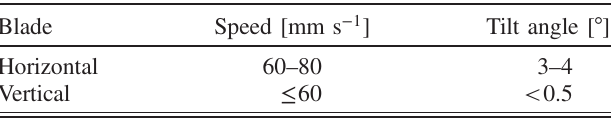
TABLE VIII. Speed and tilt angle of the tested scraper blades as reconstructed from the benchmark of simulation results against the BCT